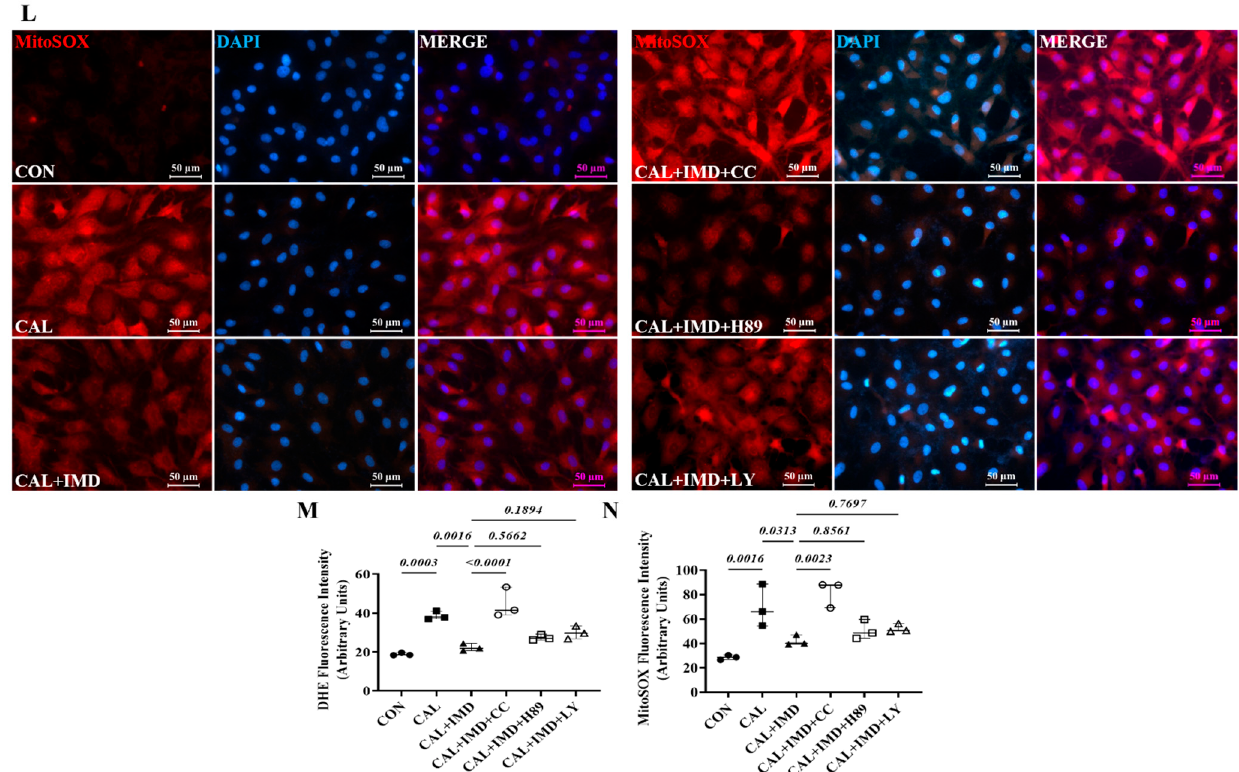
Figure 7. IMD upregulated Sirt3 via the AMPK signaling pathway. ( A ) Western blot analysis of the protein levels of phosphorylated AMP-activated protein kinase (p-AMPK) (T172), AMPK, phosphorylated protein kinase A (p-PKA) (T197), PKA, phosphorylated protein kinase B (p-Akt) (S473), and Akt in rat VSMCs preincubated with or without the phosphatidylinositol 3-kinase (PI3K) inhibitor LY294002, the AMPK inhibitor Compound C or the PKA inhibitor H89 (all 10 μ mol/L) before IMD 1–53 administration and calcification induction and quantification of ( B ) p-AMPK/AMPK, ( C ) p-PKA/PKA, and ( D ) p-Akt/Akt ( n = 3). ( E ) Alizarin red staining (Scale bar = 200 μ m), and ( F ) quantification ( n = 3). ( G ) Western blot analysis of protein levels of Sirt3, acetylation-SOD2 (K68) and SOD2 in rat VSMCs and quantification of ( H ) acetylation-SOD2 to SOD2 ratio and ( I ) Sirt3 ( n = 3). ( J ) SOD2 activity in rat VSMCs ( n = 3). ( K ) DHE probing ROS in rat VSMCs (positive staining: red). Nuclei were stained with DAPI (blue). Merged images are shown (Scale bar = 100 μ m). ( L ) MitoSOX Red probing mitochondrial-derived ROS in rat VSMCs (positive staining: red). Nuclei were stained with DAPI (blue). Merged images are shown (Scale bar = 100 μ m). ( M , N ) Average fluorescence intensity of ( M ) DHE and ( N ) MitoSOX in rat VSMCs ( n = 3). CON (solid circles): control VSMCs, CAL (solid squares): calcification VSMCs, CAL + IMD (solid triangles): calcification VSMCs with IMD 1-53 treatment, CAL + IMD + CC (open circles): calcification VSMCs with Compound C pretreatment and IMD 1-53 treatment, CAL + IMD + H89 (open squares): calcification VSMCs with H89 pretreatment and IMD 1-53 treatment, CAL + IMD + LY (open triangles): calcification VSMCs with LY294002 pretreatment and IMD 1-53 treatment Data are mean ± SD.